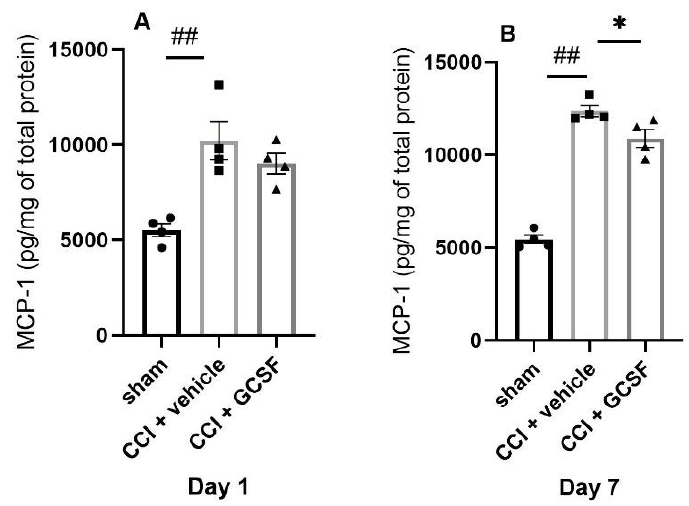
Figure 4. GCSF treatment decreased MCP-1 expression in the DRGs of CCI rats on the 7th day after nerve injury. The vehicle-treated CCI rats exhibited significantly higher MCP-1 levels in the DRGs than those exhibited by the sham-operated rats on the 1st and 7th days after nerve injury ( A , B ). In contrast, the GCSF-treated rats exhibited significantly lower MCP-1 levels in the DRGs than the vehicle-treated rats on the 7th day after nerve injury ( B ). The data are shown as the means ± SEMs (one-way ANOVA, post hoc Tukey’s test or Kruskal–Wallis, post hoc Mann–Whitney rank-sum test, if appropriate; Day 1 and 7: n = 4 per group; ## p < 0.01: vehicle-treated rats compared to sham-operated controls; * p < 0.05: GCSF-treated CCI rats compared to vehicle-treated CCI rats).